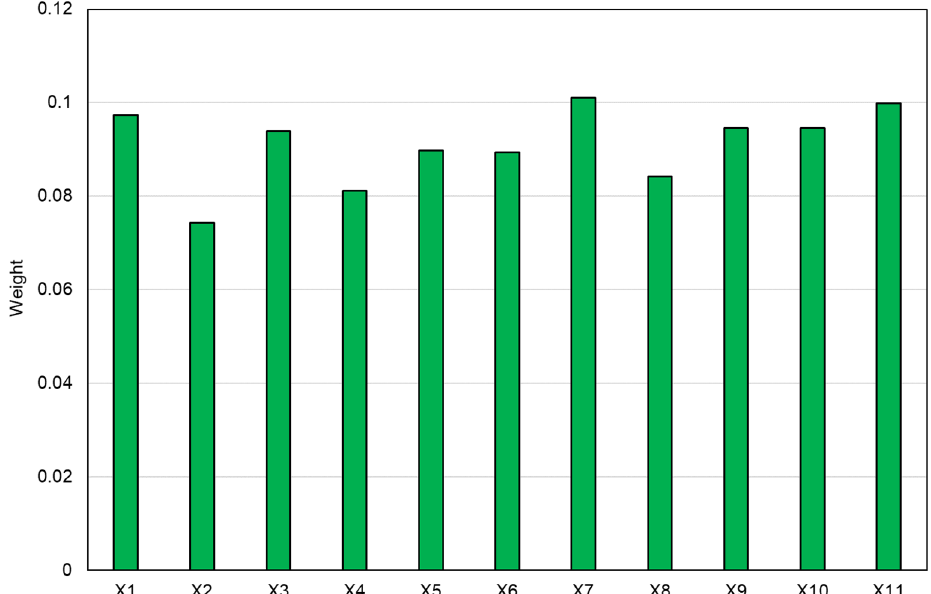
Figure 7. The weight values of SME digital maturity indicators determined by the entropy method.